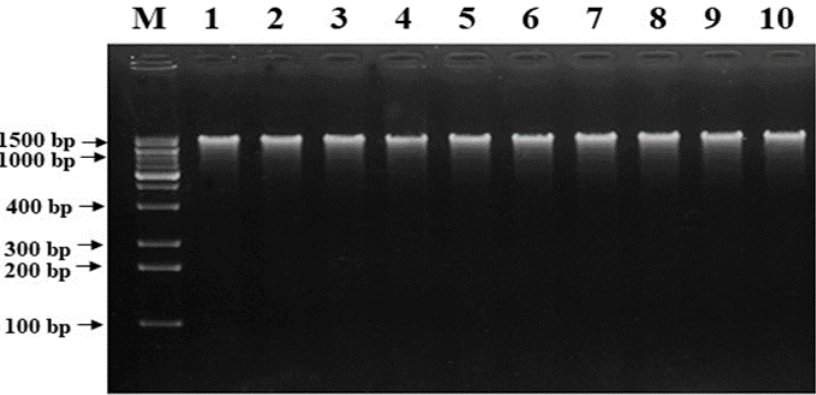
Figure 2. Agarose gel electrophoresis showing DNA extraction for 10 samples.